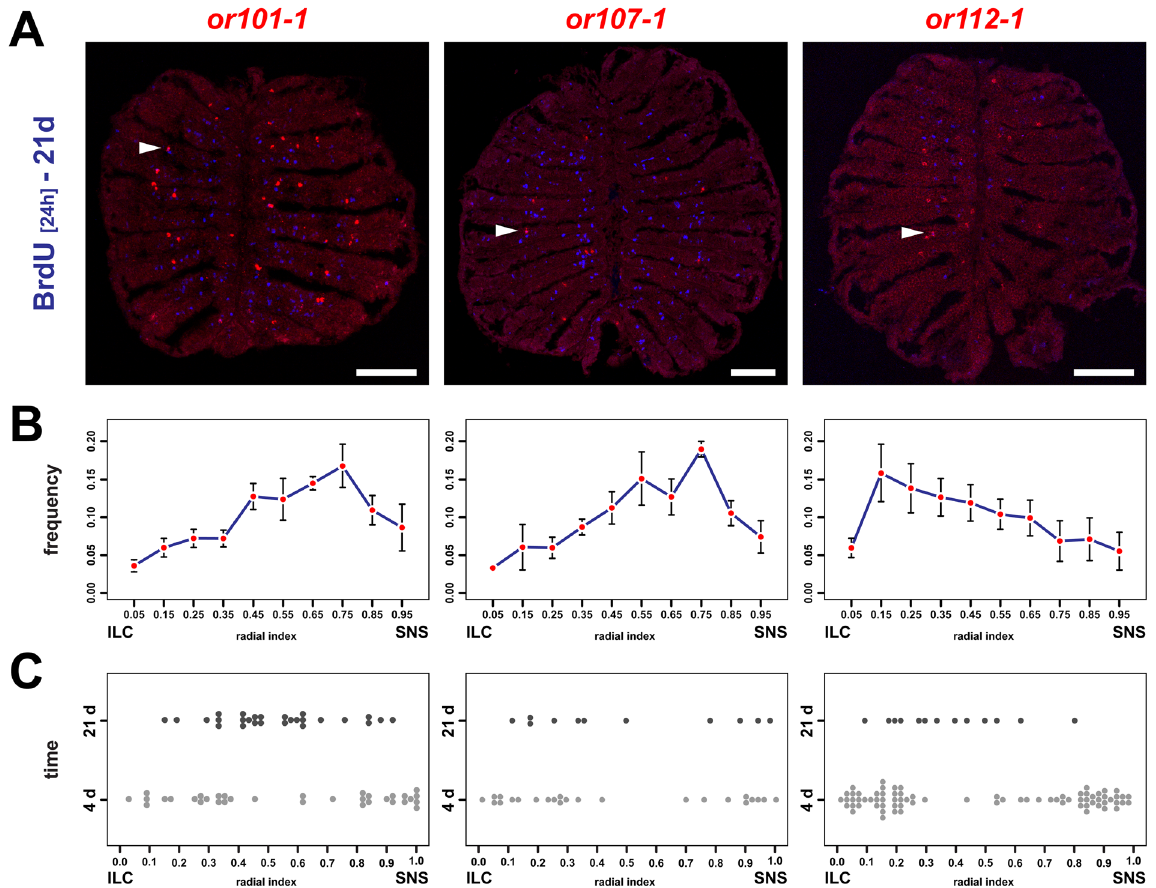
Figure 6. OSNs continue to undergo positional shifts after onset of OR expression. ( A ) Immunohistochemistry against BrdU (blue) on cross sections through the OE of adult zebrafish that were incubated for 24 h in BrdU 21d prior to analysis and simultaneous in situ -hybridization (red) for the three olfactory receptors or101 - 1 (left), or107 - 1 (centre), and or112 - 1 (right). For each receptor BrdU double-positive cells (arrowheads) can be identified. Scale bar: 100 µ m. ( B ) OR frequency distribution profiles across the radial dimension of the OE for the receptors shown in A (left: or101 - 1 , centre: or107 - 1 , right: or112 - 1 ). The position of each cell was normalized to the distance of the sensory/nonsensory border (SNS) from the tips of the interlamellar curves (ILCs). The data represent the positions (mean ± SEM) of: or101 - 1 : 755 cells from 4 OEs of 4 fish, or107 - 1 : 332 cells from 4 OEs of 4 fish, and or112 - 1 : 464 cells from 6 OEs of 3 fish. ( C ) Spatial distribution of young (4d, light grey) and old (21d, dark grey) OSNs expressing or101 - 1 (left), or 107 - 1 (centre), and or112 - 1 (right) normalized to the length of the sensory OE between the tips of the interlamellar curves (ILCs) and the sensory/nonsensory border (SNS). OSNs expressing specific OR genes continue to undergo positional shifts over